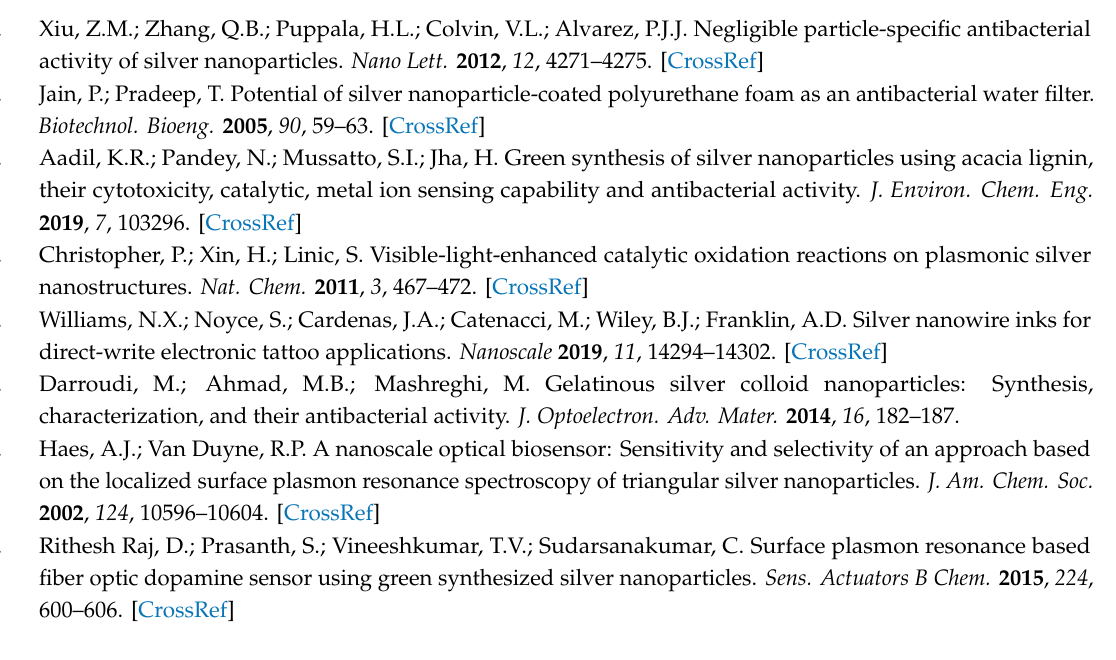
Figure S1: Example of a XANES spectrum of CNC / AgNP hybrid and its corresponding linear combination fit (LCF) using Agfoil and AgNO 3 aqueous solution as components, Table S1: R-factor and Chi-square values for the linear combination fitting procedure applied to the XANES spectra of CNC / AgNP hybrid suspension at 8.7 wt% mixed with various H 2 O 2 volumes (i.e., various H 2 O 2 / AgNP mass ratios, α ), Figure S2: (a) EXAFS spectra Fourier transform (solid gray lines) and fit (dotted lines); (b) magnitude and imaginary part (solid gray lines) and fit (dotted lines) of the Fourier transform; CNC / AgNP hybrid suspensions at 8.7 wt% AgNP treated with various H 2 O 2 volumes (i.e., di ff erent α values), Table S2: EXAFS fit results for CNC / AgNP hybrid suspensions at 8.7 wt% AgNP treated with various H 2 O 2 volumes (i.e., di ff erent α values), Figure S3: AgNP size distributions of CNC / AgNP_H 2 O 2 hybrids at (a) 8.7 wt% and 12.5 wt% AgNP and (b) 18.6 wt% and 24.7 wt% AgNP, mixed with the addition of 160 µ L of H 2 O 2 , thus varying α from 0.09 to 0.27, Table S3: Average diameter of AgNPs_H 2 O 2 in CNC / AgNP hybrids at 8.7 wt%, 12.5 wt%, 18.6 wt% and 24.7 wt% AgNP, mixed with the addition of 160 µ L of H 2 O 2 to reach various α values, Figure S4: XRD di ff ractograms of hybrids at di ff erent initial AgNP content treated with 160 µ L of H 2 O 2 (i.e., α values above and below critical value of 0.20), Table S4: R-factor and Chi-square values for the linear combination fitting procedure applied to the XANES region of CNC / AgNP hybrid suspension at various AgNP contents mixed with 160 µ L H 2 O 2 , Figure S5: (a) EXAFS spectra Fourier transform (solid gray lines) and fit (dotted lines); (b) magnitude and imaginary part (solid gray lines) and fit (dotted lines) of the Fourier transform of CNC / AgNP hybrid suspensions at various AgNP contents treated with 160 µ L of H 2 O 2 (i.e., α values from 0.09 to 0.27), Table S5: EXAFS fit results for CNC / AgNP hybrid suspensions at CNC / AgNP_H 2 O 2 hybrids at various AgNP_H 2 O 2 contents, treated with 160 µ L of H 2 O 2 (i.e., α above and below the critical value of 0.20), Figure S6: UV-Vis spectra of CNC / AgNP hybrid suspension prepared at 24.7 %wt at two di ff erent NaBH 4 / AgNO 3 molar ratios (i.e., 1.5 and 30) and then mixed with 160 µ L H 2 O 2 (i.e., α = 0.09). In our experimental conditions, such a parameter did not a ff ect the H 2 O 2 redox